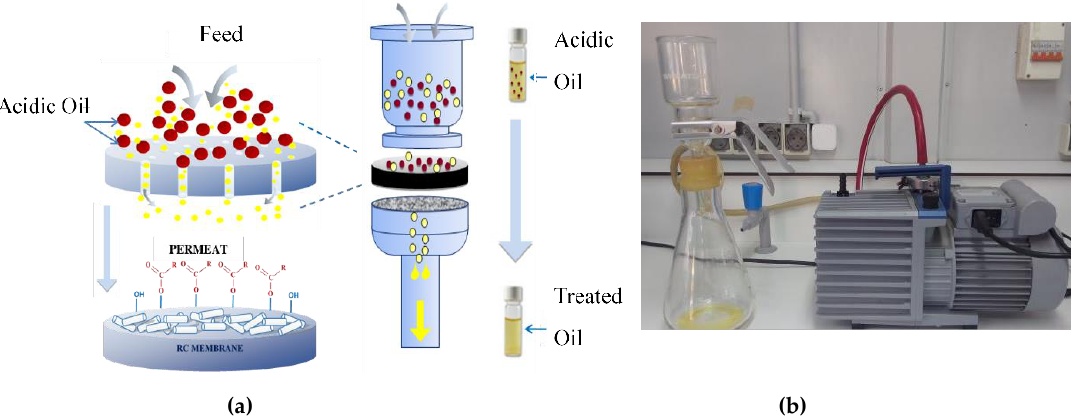
Figure 1. Scheme of the RC membrane separation adsorption mechanism and setup.